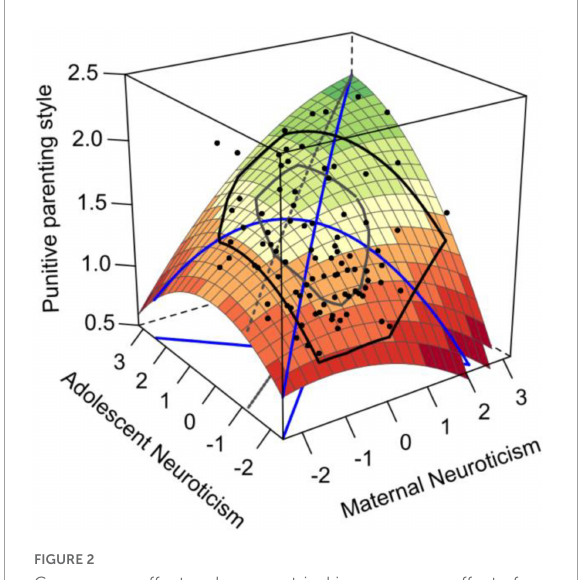
FIGURE2 Congruence effect and asymmetrical incongruence effect of maternal–adolescent neuroticism on punitive parenting style.